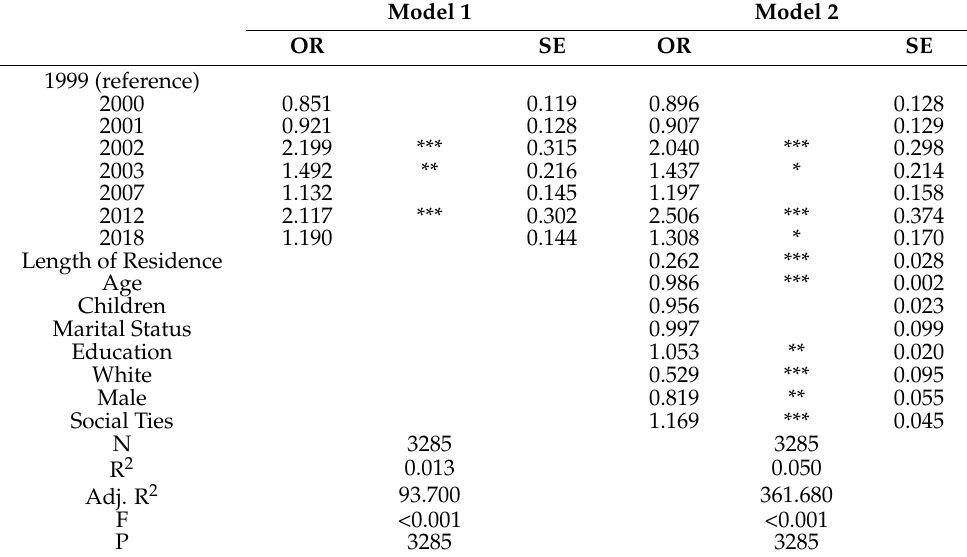
Table 4. Change in Community Desirability Over